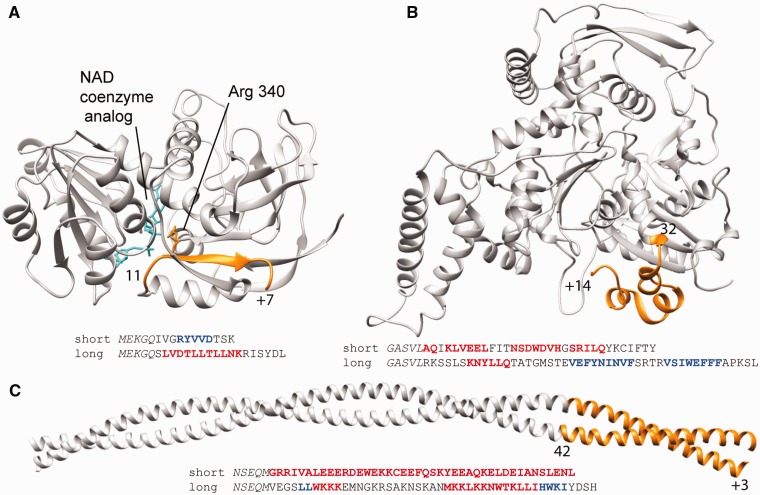
Three proteins with additions that may impact protein structure. (A) Alcohol dehydrogenase I from S. cerevisiae S288C, PDB ID 2HCY, chain A, residues 1–347, (B) Actin-related protein 8 from S. cerevisiae S288C, PDB ID 4AM6, chain A, residues 248-881, (C) Tropomyosin 2, homolog from O. cuniculus shown, PDB ID 2W49, chains A and B, residues 39–200. The ribbon diagram in each panel shows the portion of the protein altered by frameshift in orange, with the length of the altered region as well as the increase in sequence length indicated. Below each structure the C-terminal sequences of the reference strain and the longest version are shown, preceded by five residues of the unaltered region of sequence, shown in italics. Sequences are annotated with actual or predicted locations of α-helix (red) and β-strand (blue) secondary structures. These locations are inferred from the S. cerevisiae S288C or homologous structure in the case of the reference strain, or predicted by Jpred 3 in the case of the longest version.